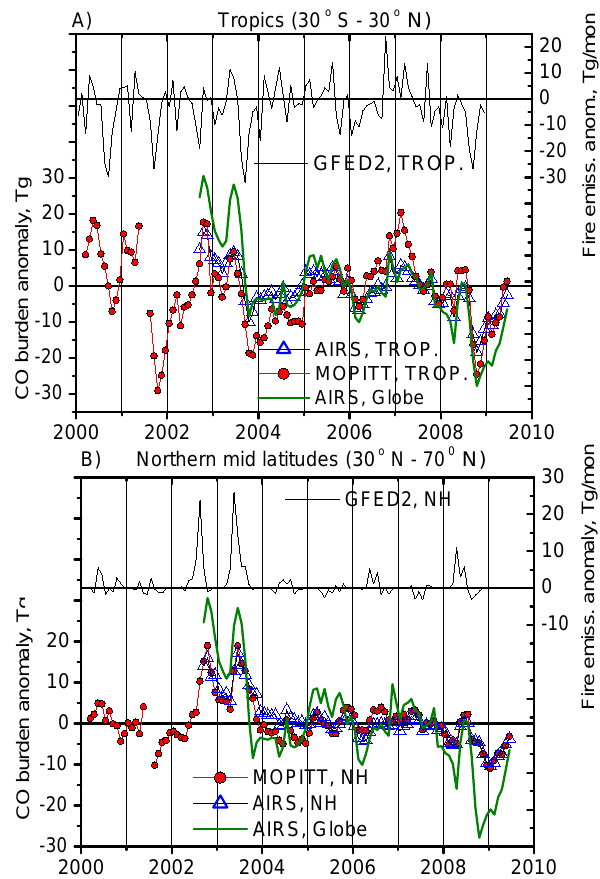
Fig. 11. CO burden regional anomalies compared with emission from biomass burning. (A) Top panel: anomalies of CO emission from biomass burning according to GFED2. Bottom panel: anoma- lies of CO burden for the tropical belt measured by the two satellite sounders as corrected in Sect. 2. The anomalies of global burden are shown for comparison. (B) The same as in (A), but for Northern